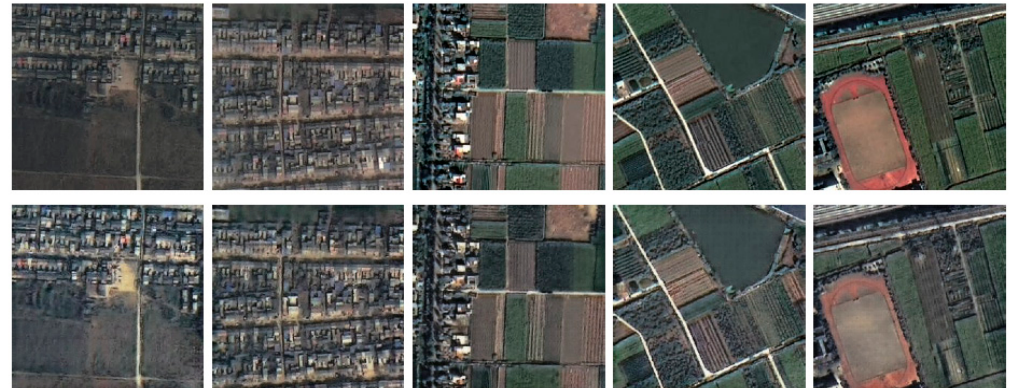
Figure 9. Dehazed results of haze-free remote-sensing images: the first row shows the haze-free images; the second row shows the dehazed results of the first-row images.